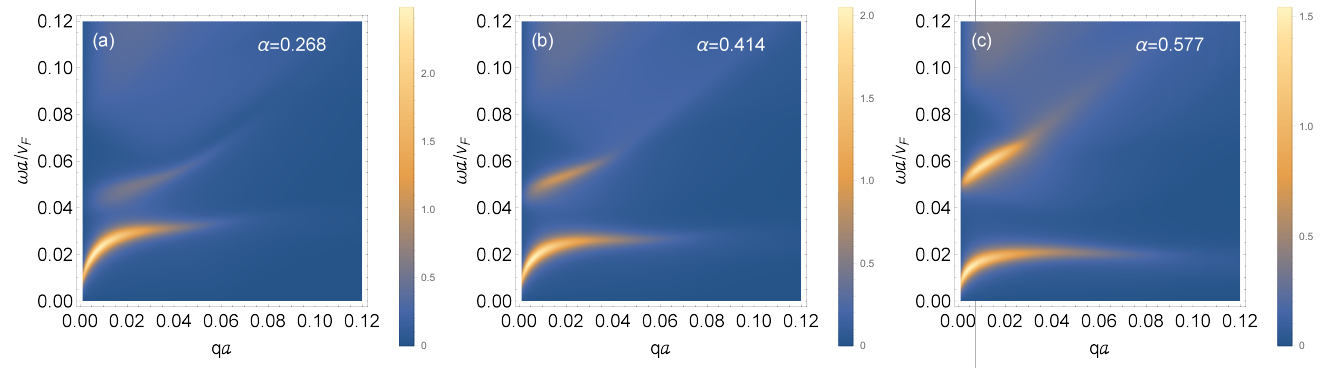
Figure 4. Density plots of the magnetoplasmons dispersion for an α – T 3 lattice in low magnetic field for chosen temperature T = 0 K, mass term ∆ a /¯ hv F = 0.05 and various values of the hopping parameter α , ( a ) α = 0.268, ( b ) α = 0.414 and ( c ) α = 0.577. The Fermi energy µ a /¯ hv F = − 0.0125 is within the middle